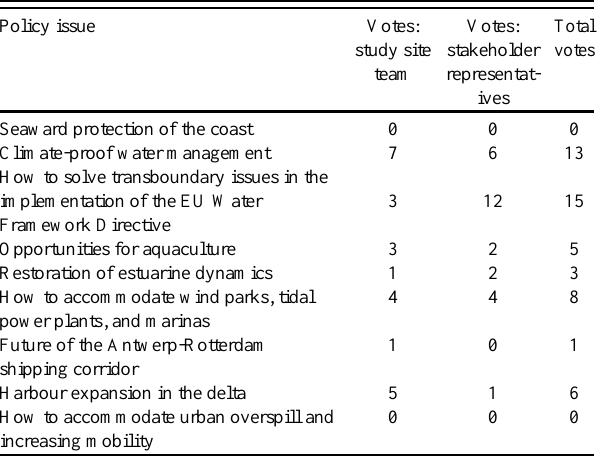
Table 1. Prioritizing policy issues addressed in the Scheldt River basin case. Each of the 17 participants had three votes to